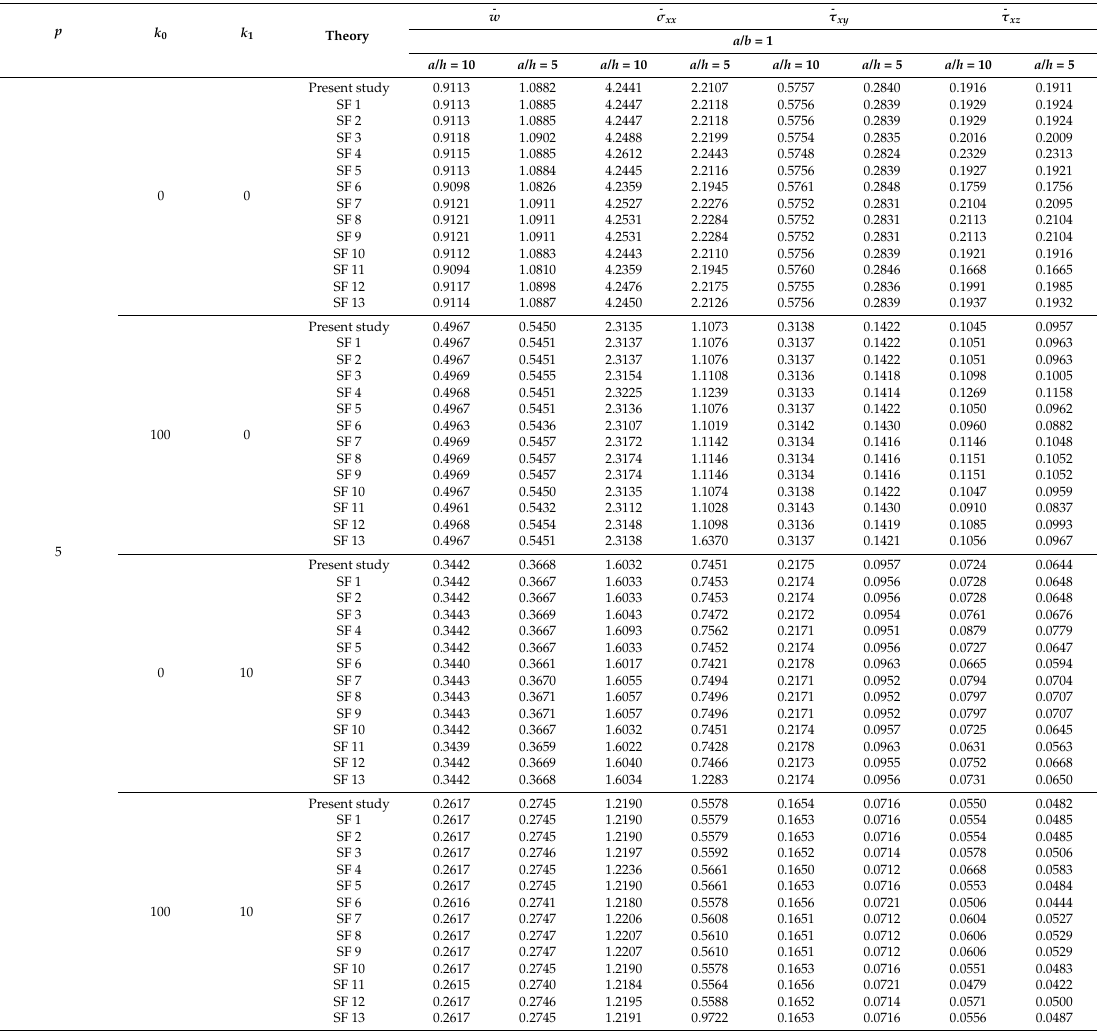
Table 4. Normalized values of displacement and stresses of square plate on elastic foundation for p = 5, different values of the k 0 и k 1 and the ratio a / h ( a / b =